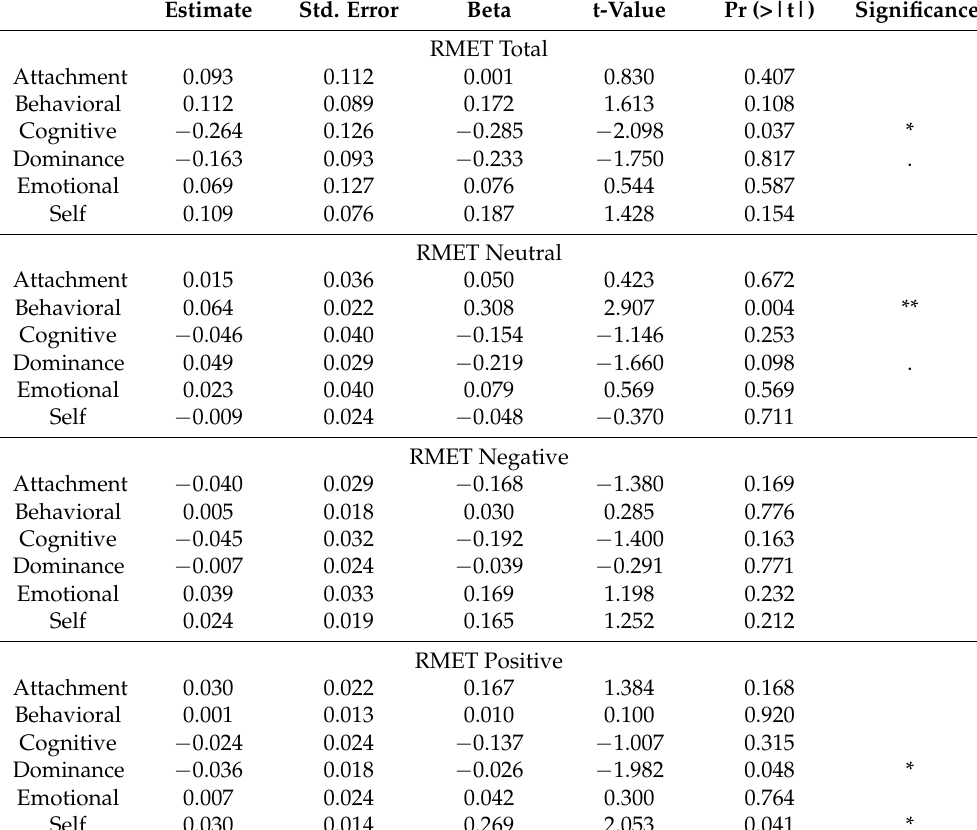
Table 4. This table shows the CAPP/RMET multiple regression